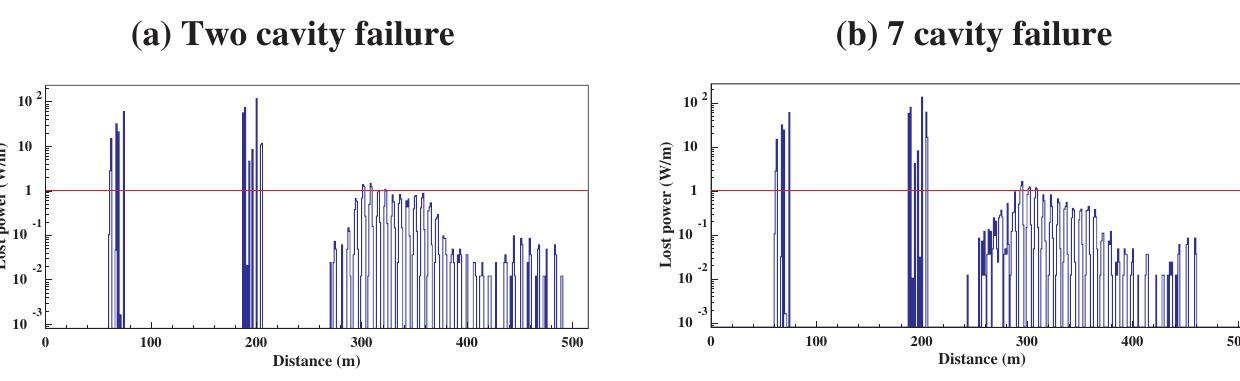
FIG. 9. (Color) Beam loss in W = m along the RIA driver linac for the cases of (a) two cavities and (b) 7 cavities failure in the medium- (cid:1) where the automatic tuning procedure was used to retune the linac and restore the beam. We notice that in both cases an optimized tune with limited beam loss is obtained.